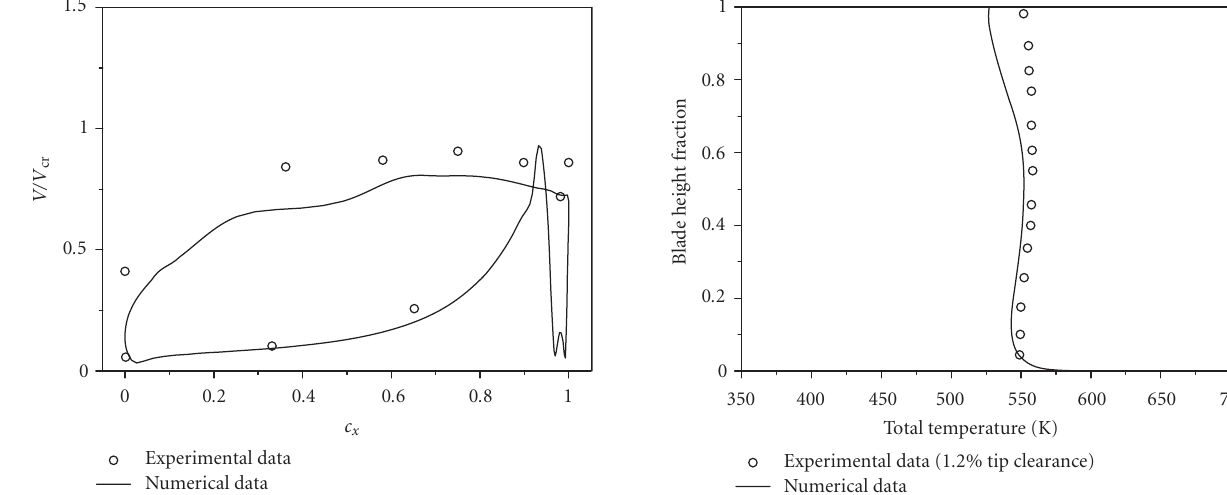
Figure 5: Critical velocity ratio at the tip of the vane.